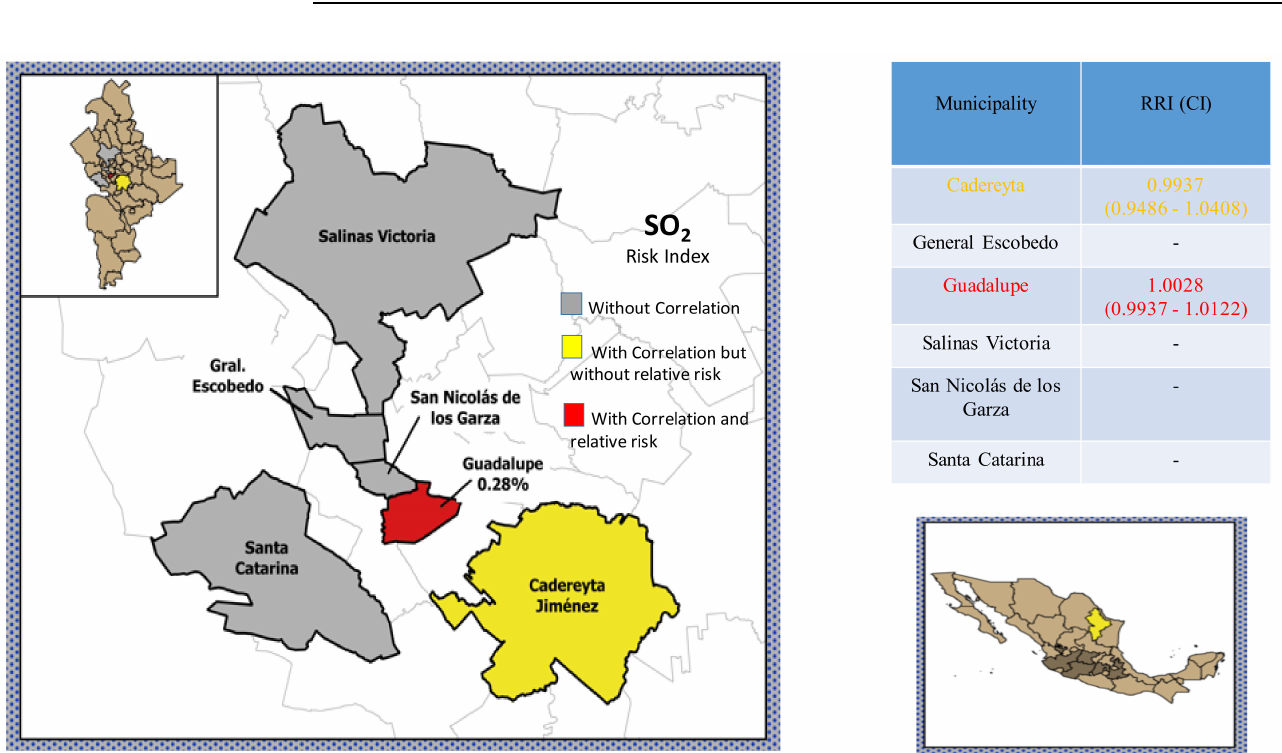
Figure 13. Relative risk indexes in MAM for the hypothetical scenario in which daily mean concentrations for SO 2 increased by 10%, considering all